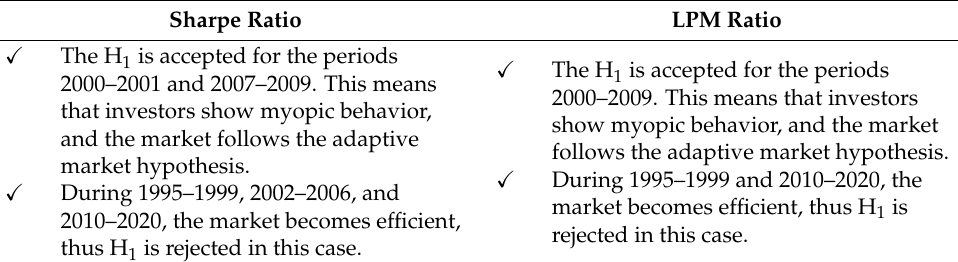
Table 5. Overall acceptance and rejection of Hypothesis. Sharpe